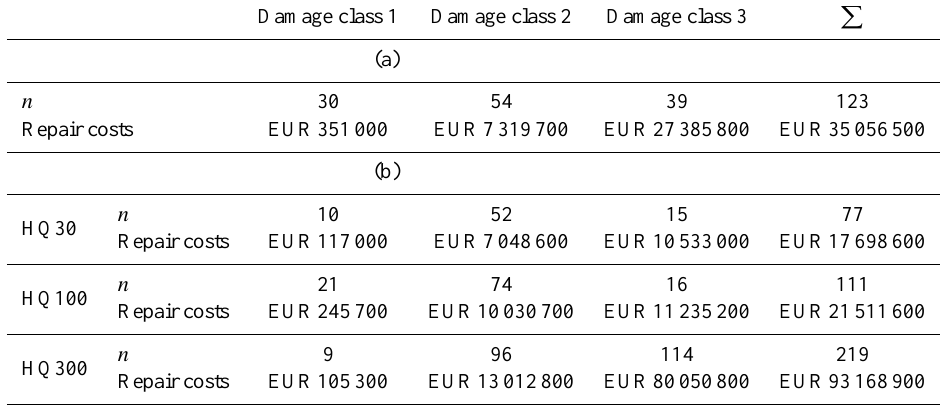
Table 3. Estimated frequencies of damage classes and resulting repair costs for (a) the March flood in 2006 and (b) for different hydraulic